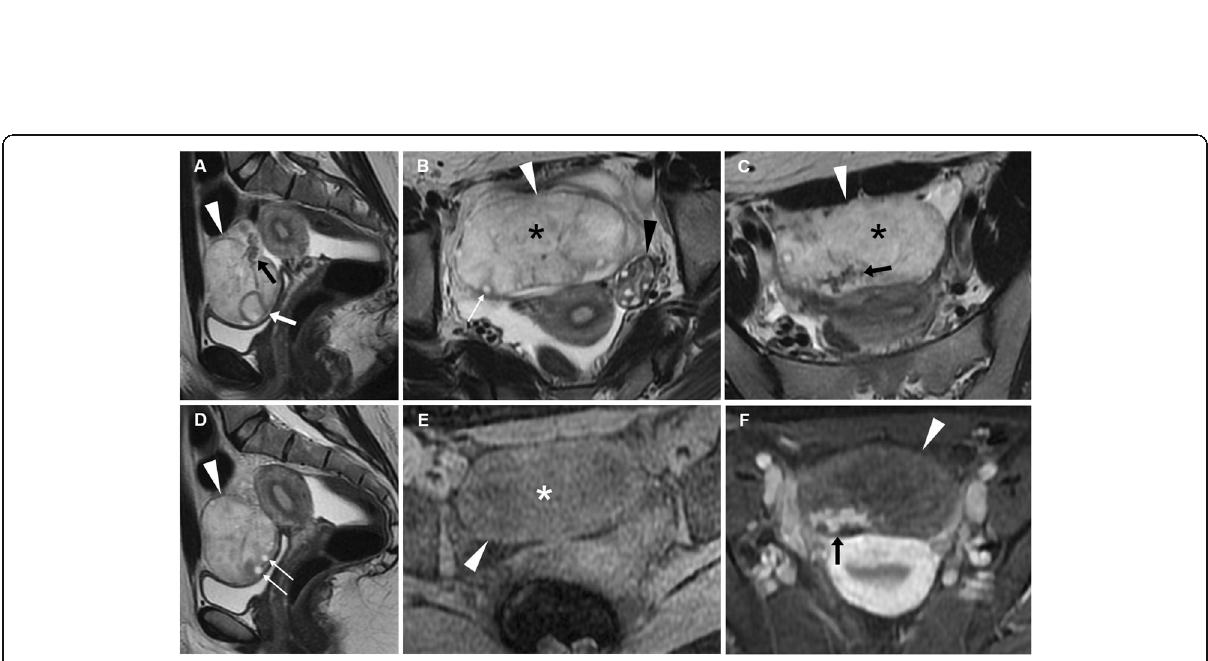
Fig. 19 Right adnexal torsion in a 24-year-old woman with acute abdominal pain and leukocytosis. Multiplanar T2-weighted ( a – d ), oblique-axial precontrast fat-suppressed T1-weighted ( e ) and oblique-axial gadolinium-enhanced fat-suppressed T1-weighted ( f ) images show an enlarged (10 cm diameter) right ovary (arrowheads) with afollicular T2-hyperintense central stroma (asterisk in b and c ), peripheral follicles ( ‘ pearl string sign ’ , thin arrows in b and d ) and corpus luteum (arrow in a ). The normal left ovary is also seen (black arrowhead in b ). Note the engorged blood vessels along the posterior portion of the right adnexa (black arrows in a , c and f ). The enlarged right ovary shows homogeneous intermediate T1-weighted signal intensity (asterisk in e ), without hyperintense haemorrhagic changes, reflecting the early stage of torsion. The patient underwent laparoscopic detorsion with adnexal